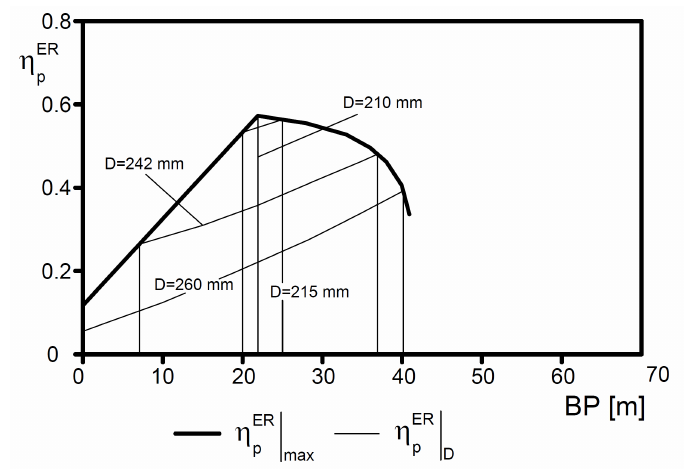
Figure 4. Efficiency variability of different machines with ER.